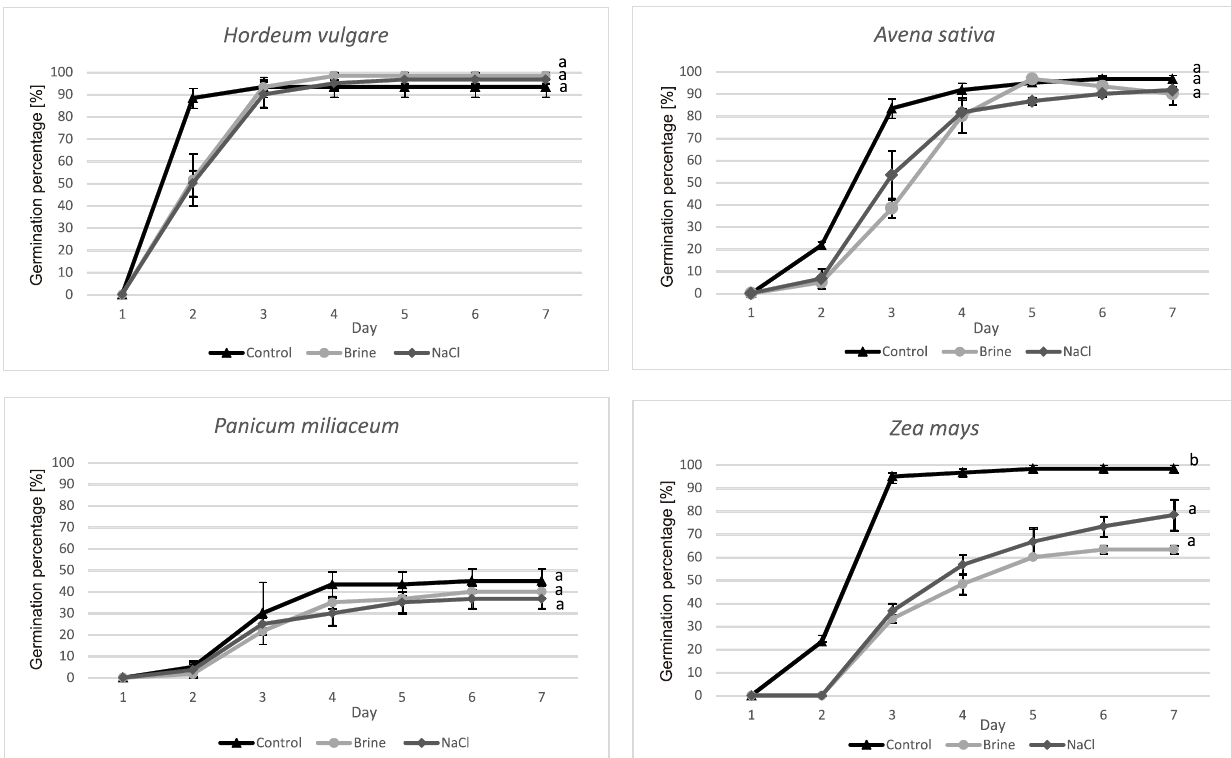
Figure 1. Germination percentage (GP) of model plants. Significant differences ( p < 0.05) are marked by different letters. Average values ( X ) with standard error (SE) are given ( X ± SE), n =